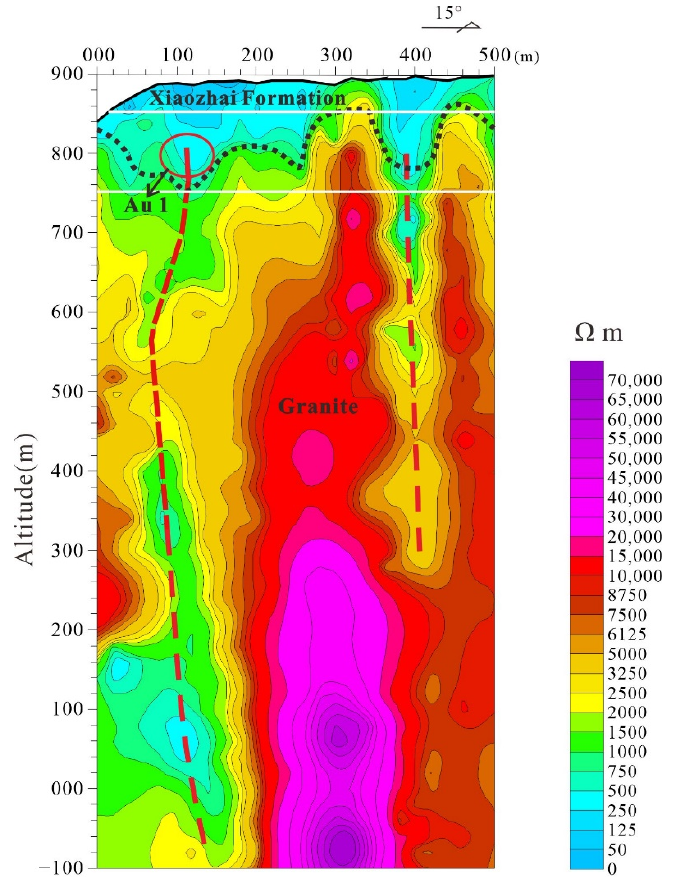
Figure 6. EH4 sounding image of Line 10 in the Xinping section of the Jianbeigou gold mine. The dashed line in the profile is the inferred geological boundary between the strata and the granite. The thick dashed red lines are the presumed mineralized zone. The thick, short solid red line is the know ore body location in the Xinping mine section. The white lines are the location of the exploration adit at 750 m and 850 m.